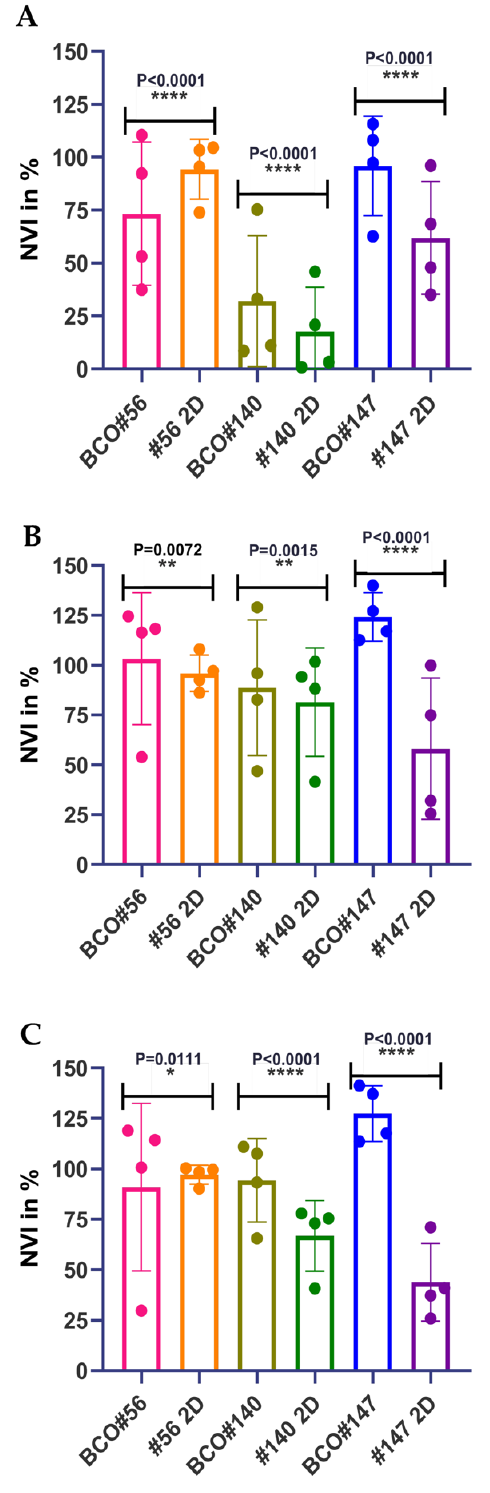
Figure 6. Comparing cell viabilities after drug treatment in organoids and adherent cells. BCOs and the corresponding tumor cells were incubated for 1, 2, and 3 days with CIS ( A ), VTX ( B ), and S63 ( C ), respectively, to determine the cell viability in 3D organoids in comparison to the same cells in adherent 2D standard culture. The mean normalized viability indices in percent (NVI %; ordinate, Y-axis), statistical differences, and p-values were computed in the corresponding cohorts as indicated (abscissa, X-axis). * p = 0.0111, ** p = 0.0072 & 0.0015, *** p < 0.001, **** p < 0.0001.